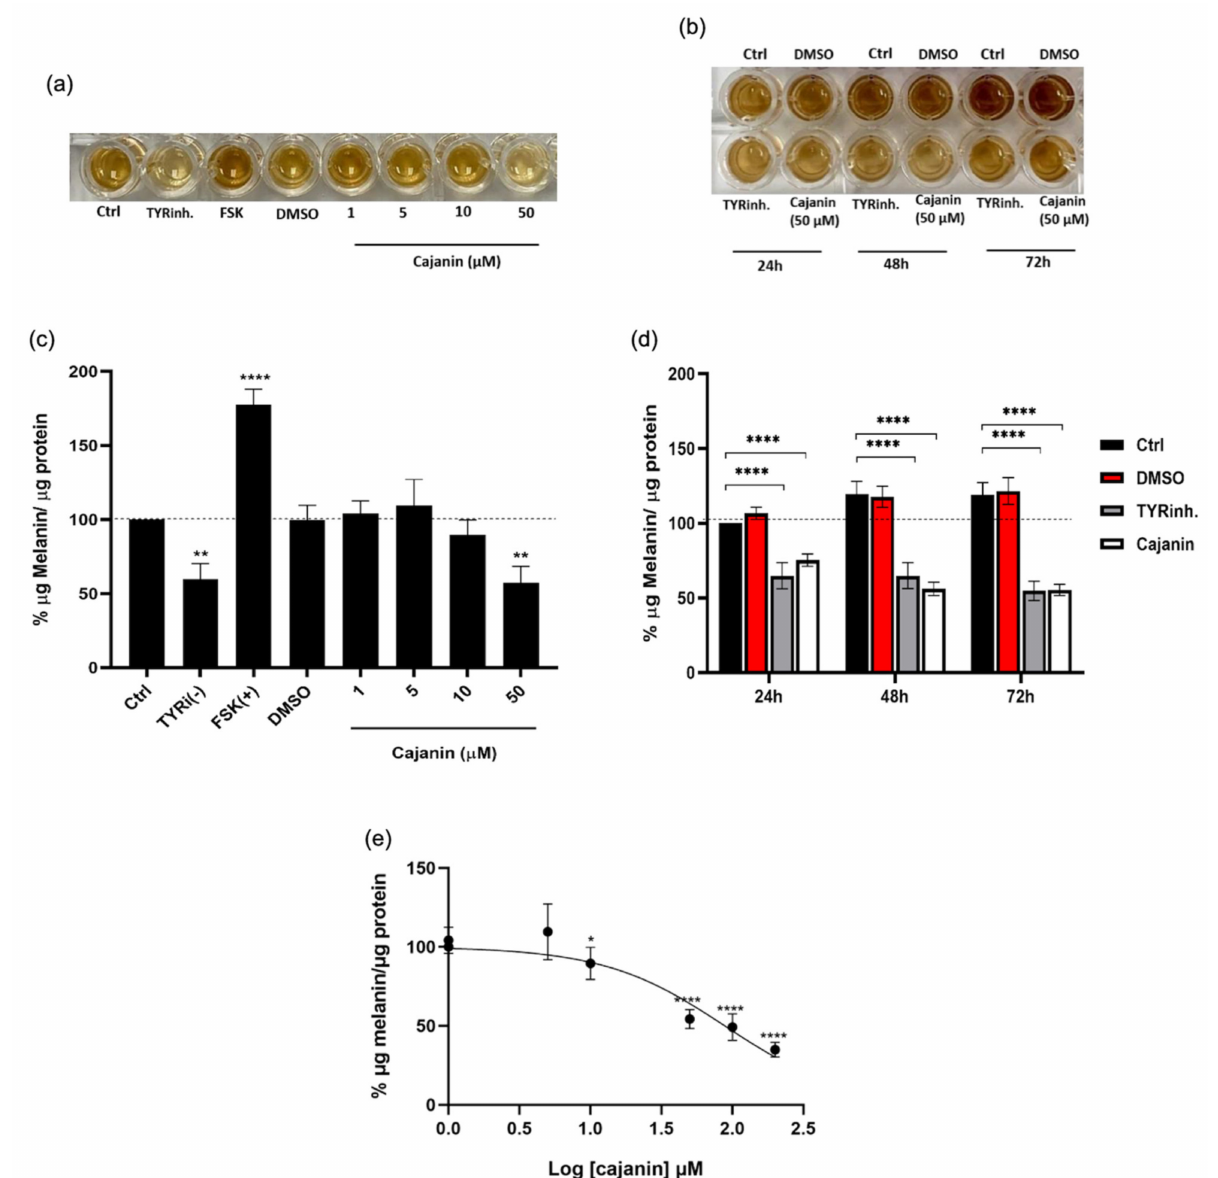
Figure 3. Cajanin inhibits melanin production in human MNT1 cells. ( a , c ) After treatment with cajanin (1–50 µ M), 20 µ M tyrosinase inhibitor (TYRi; 4-butylresorcinol), 10 µ M forskolin (FSK) or vehicle (DMSO) for 72 h, the cellular melanin content was determined in human melanoma MNT1 cells. ( b , d ) The inhibitory effect of cajanin (50 µ M) on melanin synthesis in MNT1 cells was promptly observed at 24 h and sustained until 48–72 h of the incubation time. ( e ) The dose response curve demonstrates 50% reduction of melanin content in human melanin-producing MNT1 cells cultured with cajanin approximately at 77.47 ± 9.28 µ M for 72 h. The melanin content is calculated from the ratio between amount of cellular melanin and total protein content relatively to the untreated control cells. Experiments were performed in triplicate and data are expressed as mean ± SEM. * p < 0.05, ** p < 0.01, **** p < 0.001 versus non-treated cells (Ctrl). The relationship between cellular melanin content and concentration in logarithmic (log) scale was generated for determining the half maximum inhibitory concentration (IC 50 ) of cajanin in human melanin-producing cells. As indicated in Figure 3e, the 72-h treatment with cajanin at 77.47 ± 9.28 µ M possessed approximately 50% inhibition of melanin production in human MNT1